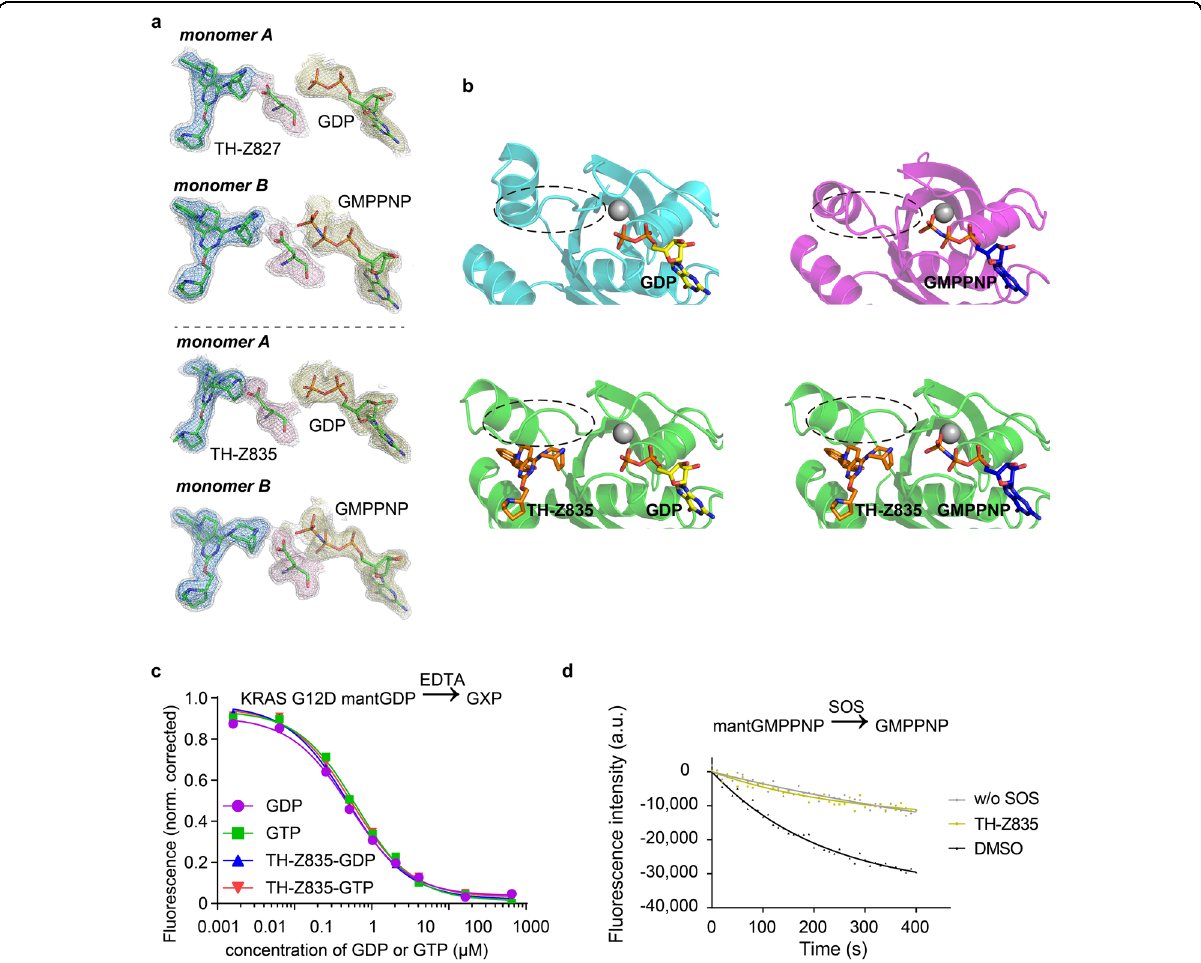
Fig. 3 G12D inhibitors bind to both GDP-bound and GMPPNP-bound KRAS. a Upper panel: Fo-Fc map of TH-Z827, Asp12, and GDP (PDB ID: 7EWA, monomer A). Fo-Fc map of TH-Z827, Asp12, and the GTP analog GMPPNP (PDB ID: 7EWA, monomer B). Lower panel: Fo-Fc map of TH-Z835, Asp12, and GDP (PDB ID: 7EWB, monomer A). Fo-Fc map of TH-Z835, Asp12, and GMPPNP (PDB ID: 7EWB, monomer B). In all graphs, the 1.5 σ Fo-Fc maps of all shown elements are shown in gray mesh. The color scheme of 2.5 σ Fo-Fc maps is: blue for inhibitors, pink for Asp12, and yellow for nucleotides. b KRAS(G12D) conformational change analysis for drug-free GDP-bound protein (PDB: 4EPR), drug-free GMPPNP-bound protein (PDB: 5USJ), TH-Z835 and GDP-bound protein (PDB: 7EWB, chain A), and TH-Z835 and GMPPNP-bound protein (PDB: 7EWB, chain B). c EDTA-mediated competition between fl uorescently labeled mantGDP loaded on KRAS and free nucleotide (GDP or GTP). The experiment was carried out with KRAS (G12D) alone or with KRAS(G12D) treated with TH-Z835. d Inhibitory activity of TH-Z835 measured by SOS-catalyzed nucleotide exchange assays with GMPPNP as the incoming